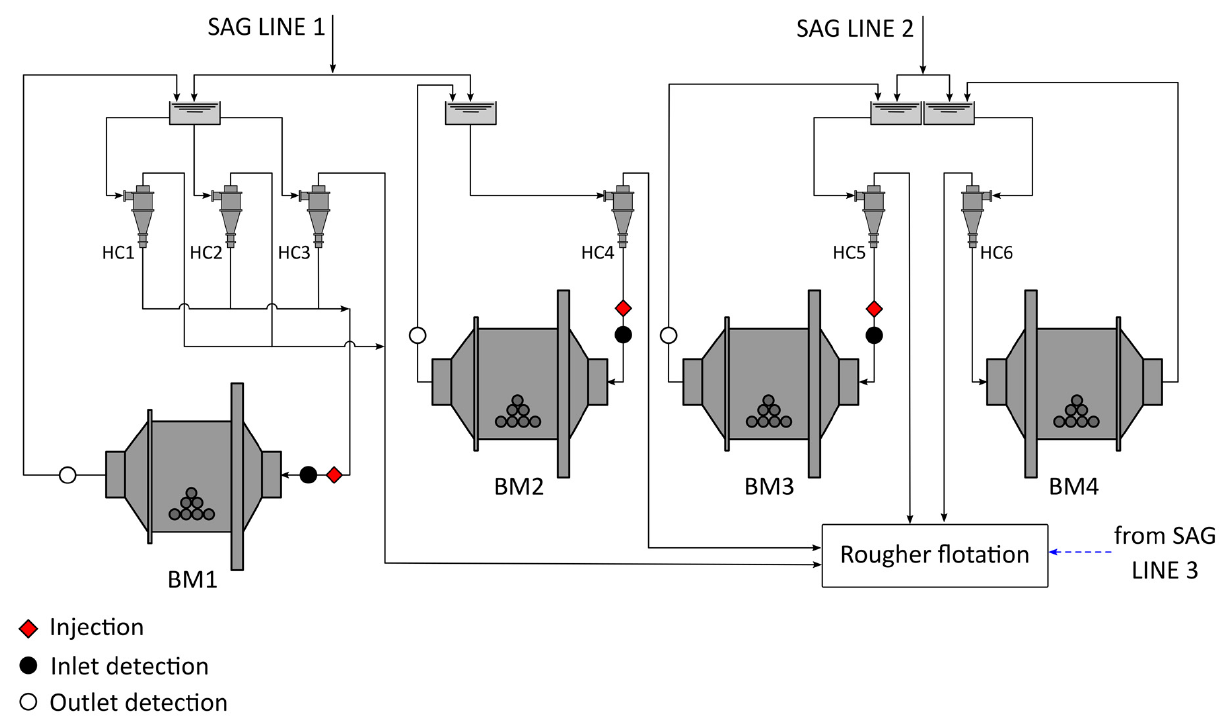
Figure 1. Schematic of the grinding circuit including the SAG lines 1 and 2. The injection and de- tection points are shown for the ball mills BM1, BM2 and BM3. detection points are shown for the ball mills BM1, BM2 and